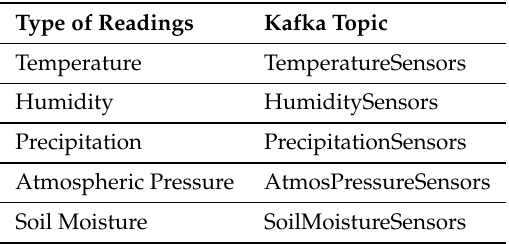
Table 3. Categorisation of the Sensors Readings to Kafka